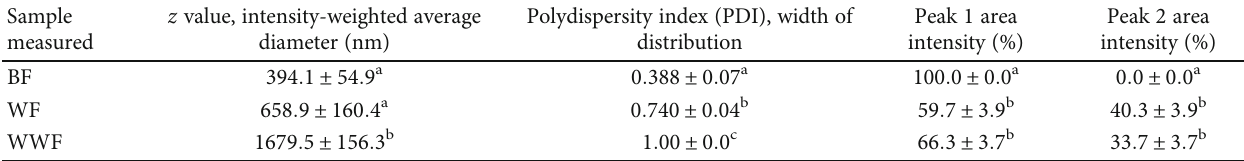
The data is presented as mean ± SD . The values with di ff erent superscripts in a column di ff er signi fi cantly at p ≤ 0 : 05 . Legends: BF: chickpea fl our; WF: white fl our; WWF: whole wheat fl our.